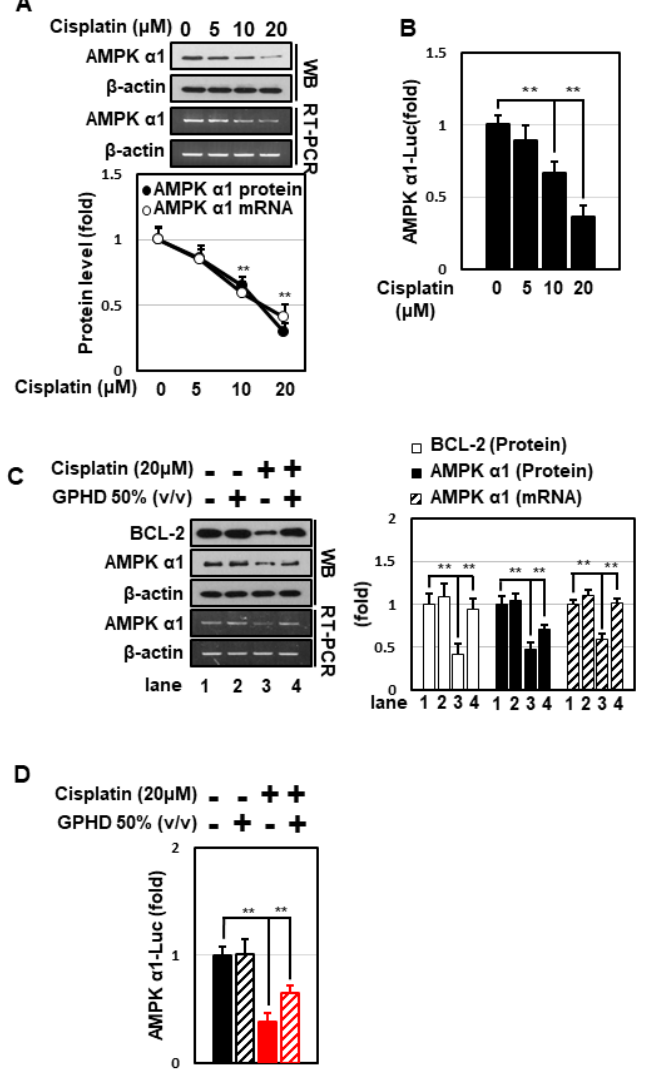
Figure 2. GPHD effectively prevents cisplatin ‐ induced inhibition of AMPK α 1 transcription. HEK293 cells were treated with cisplatin and/or GPHD for 24 h, and then Western blot analysis or RT ‐ PCR was performed ( A , C ). HEK293 cells were transfected with a pGL3 luciferase reporter vector containing a human AMPK α 1 promoter (~1.7 kb). After the indicated treatment for 24 h, luciferase activity was measured ( B , D ). WB, Western blotting; RT ‐ PCR, reverse transcriptase ‐ polymerase chain reaction. The results shown are representative of the three independent experiments. p ‐ value < 0.05 was considered statistically significant; individual p ‐ values (* p < 0.05; ** p < 0.01) are indicated in figures.